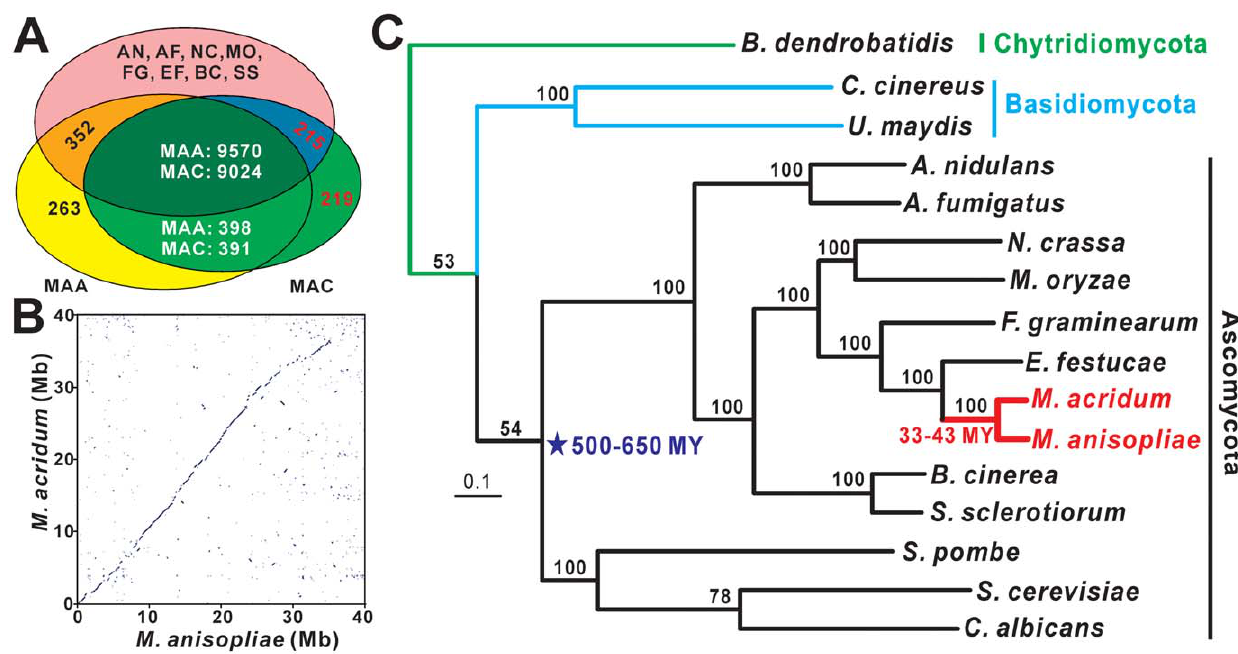
Figure 2. Homology, syntenic, and phylogenomic relationships of M.anisopliae and M.acridum . (A) Predicted proteins in M. anisopliae (MAA) and M. acridum (MAC) were compared with the genome encoding proteins of Aspergillus nidulans (AN), A. fumigatus (AF), Neurospora crassa (NC), Magnaporthe oryzae (MO), Fusarium graminearum (FG), Epichloe¨ festucae (EF), Botrytis cinerea (BC) and Sclerotinia sclerotiorum (SS). The diagram was constructed with a cut off E- value , 1 6 10 2 5 . (B) Dot blot of M. anisopliae and M. acridum using ordered scaffold data. (C) Phylogenetic tree constructed using the Dayhoff amino acid substitution model showing the evolutionary relationships of 16 fungal species. MY= million years.